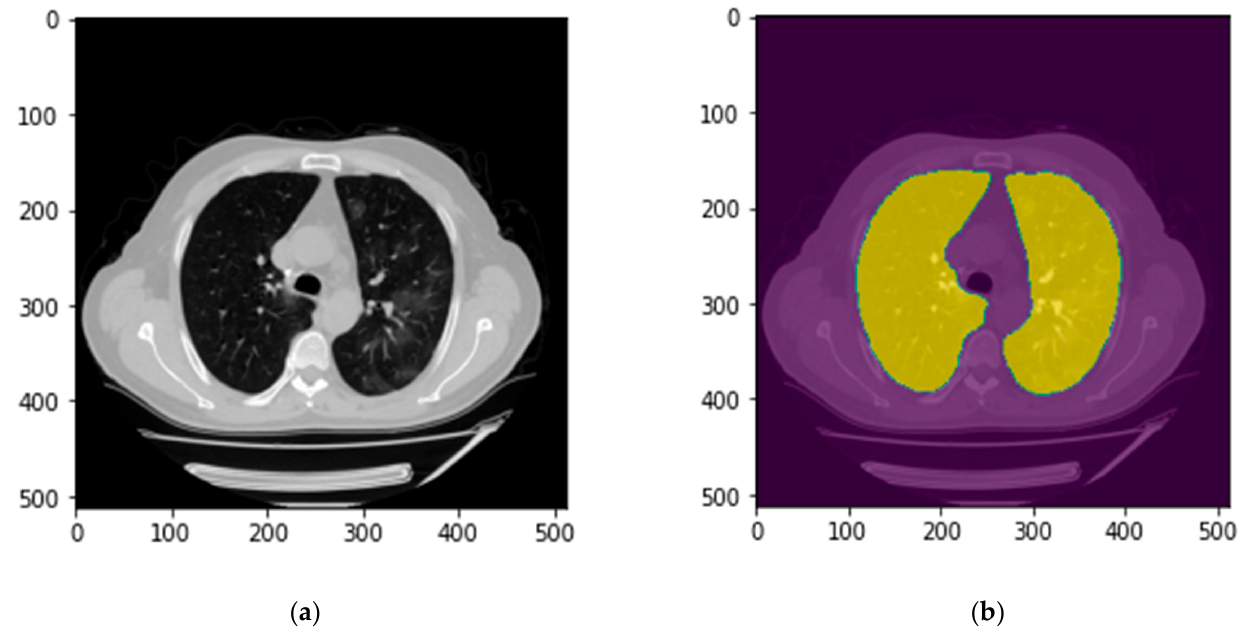
Figure 3. An example of the lung segmentation. ( a ) Raw CT image; ( b ) CT image and lung mask.